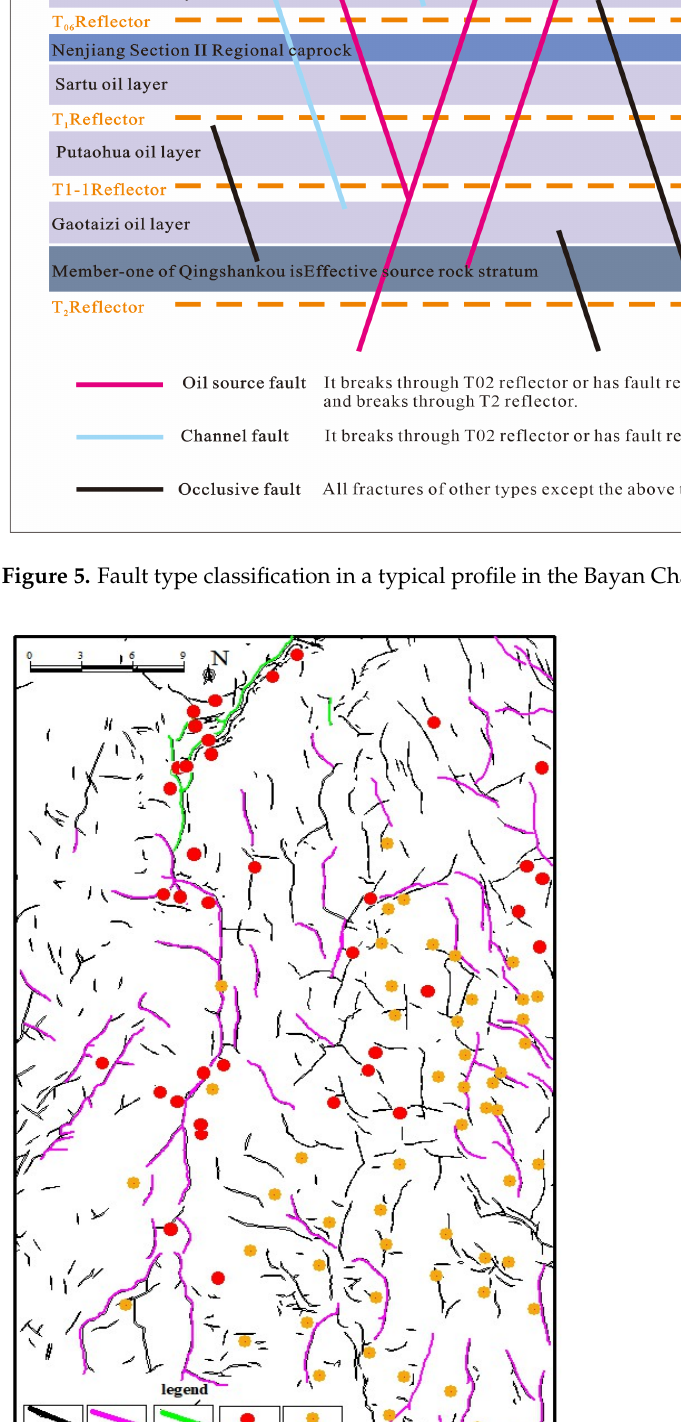
Figure 6. Distribution of migrated hydrocarbon fluid at the Saertu reservoir and the Heidimiao res- ervoir from the Putaohua reservoir in the Bayan Chagan area.